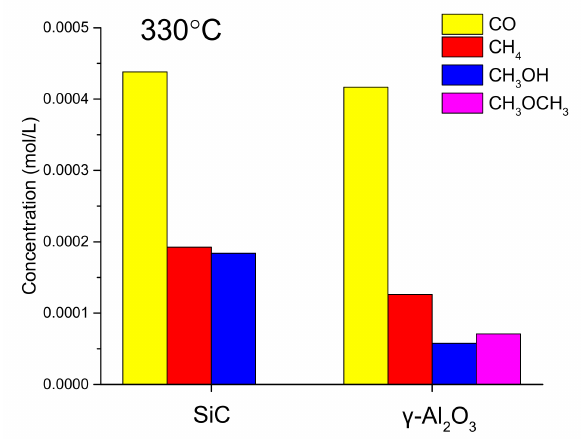
Figure 7. The composition of the gas phase products of methyl palmitate HDO obtained over Ni 2 P/SiO 2 – γ -Al 2 O 3 system (at 99.7% conversion of MP) and Ni 2 P/SiO 2 –SiC (at 91.6% conversion of MP). Reaction conditions: P H —3.0 MPa, H 2 /feed—600 Nm 3 /m 3 , WHSV—5 h − 1 2